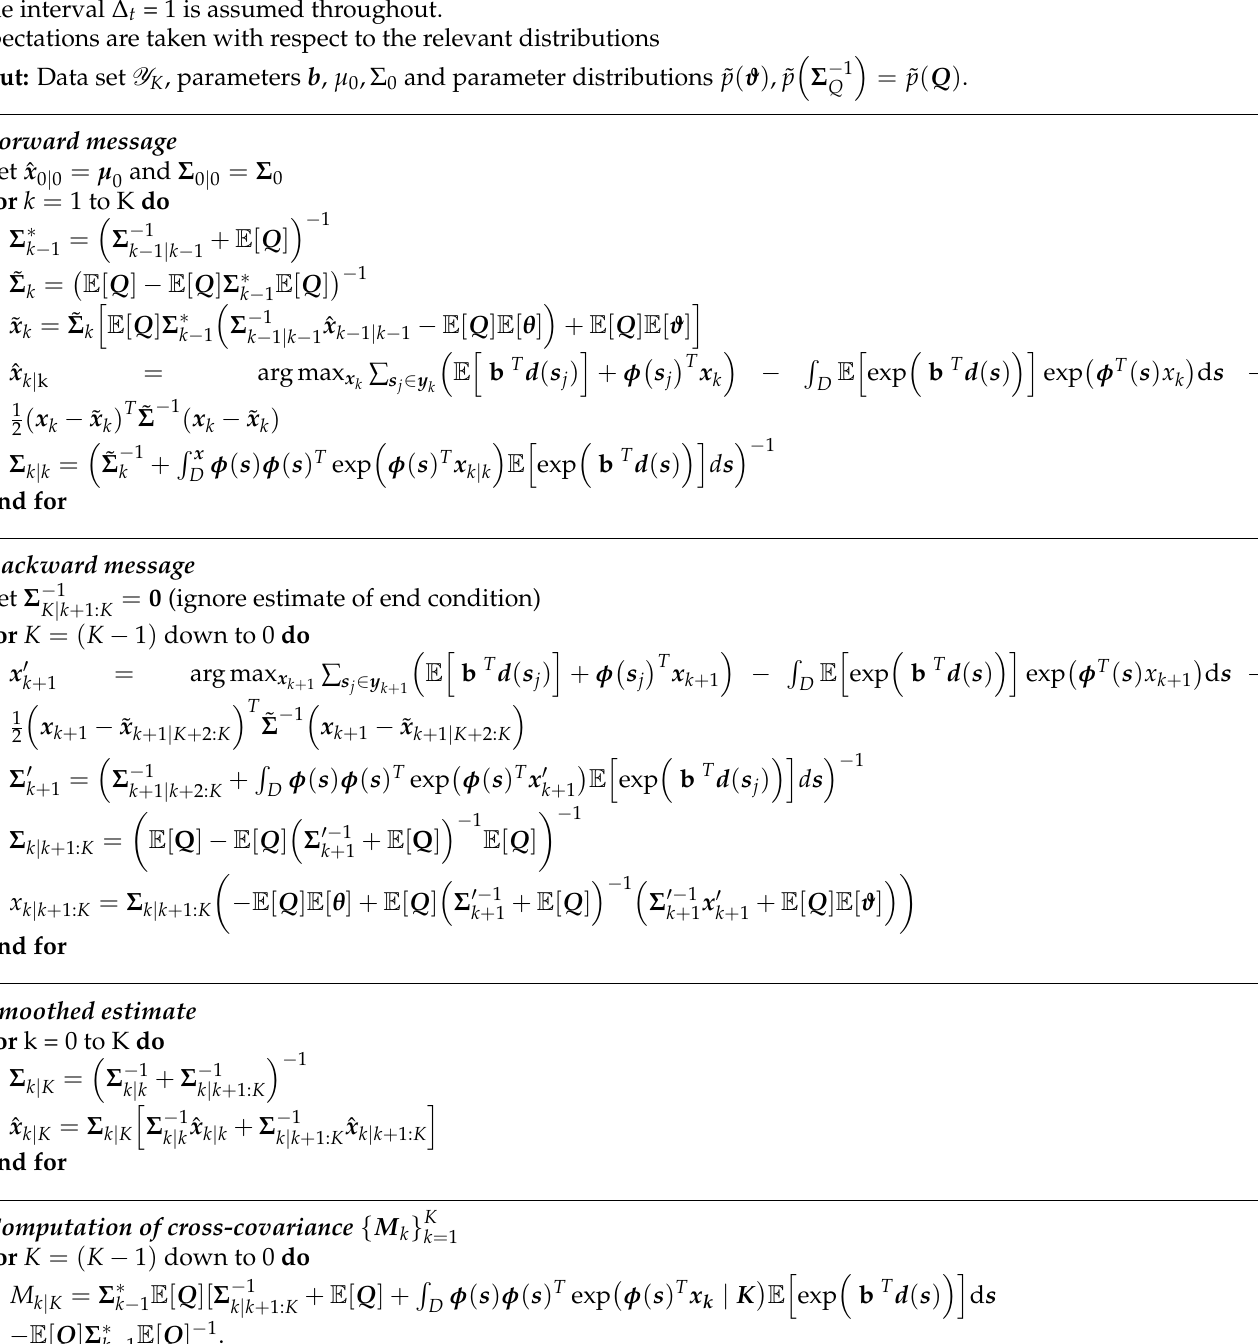
Algorithm 2 VB-Laplace smoothers (adapted from Zammit-Mangion et al. [19]). Time interval ∆ t = 1 is assumed